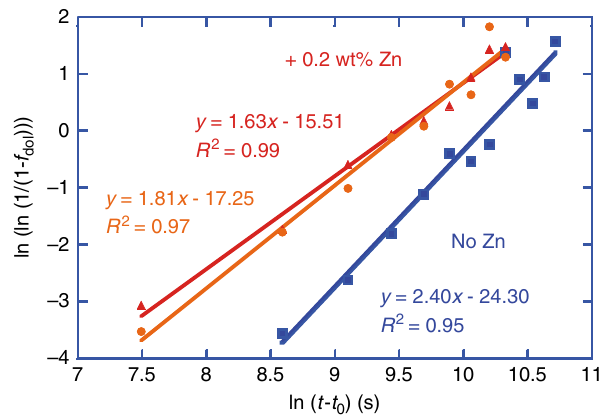
Fig. 5 Avrami plot for dolomitization of calcite at 200 °C. The linear best fi t trend lines enable derivation of time exponent and rate constant for the control dolomitization experiments (blue), ZnCl 2 dolomitization experiments (red), and ZnO dolomitization experiments